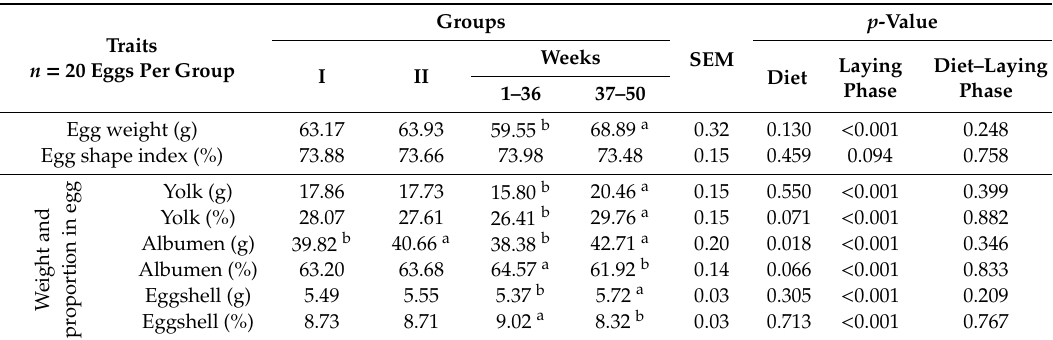
Table 6. Parameters of egg morphology and egg